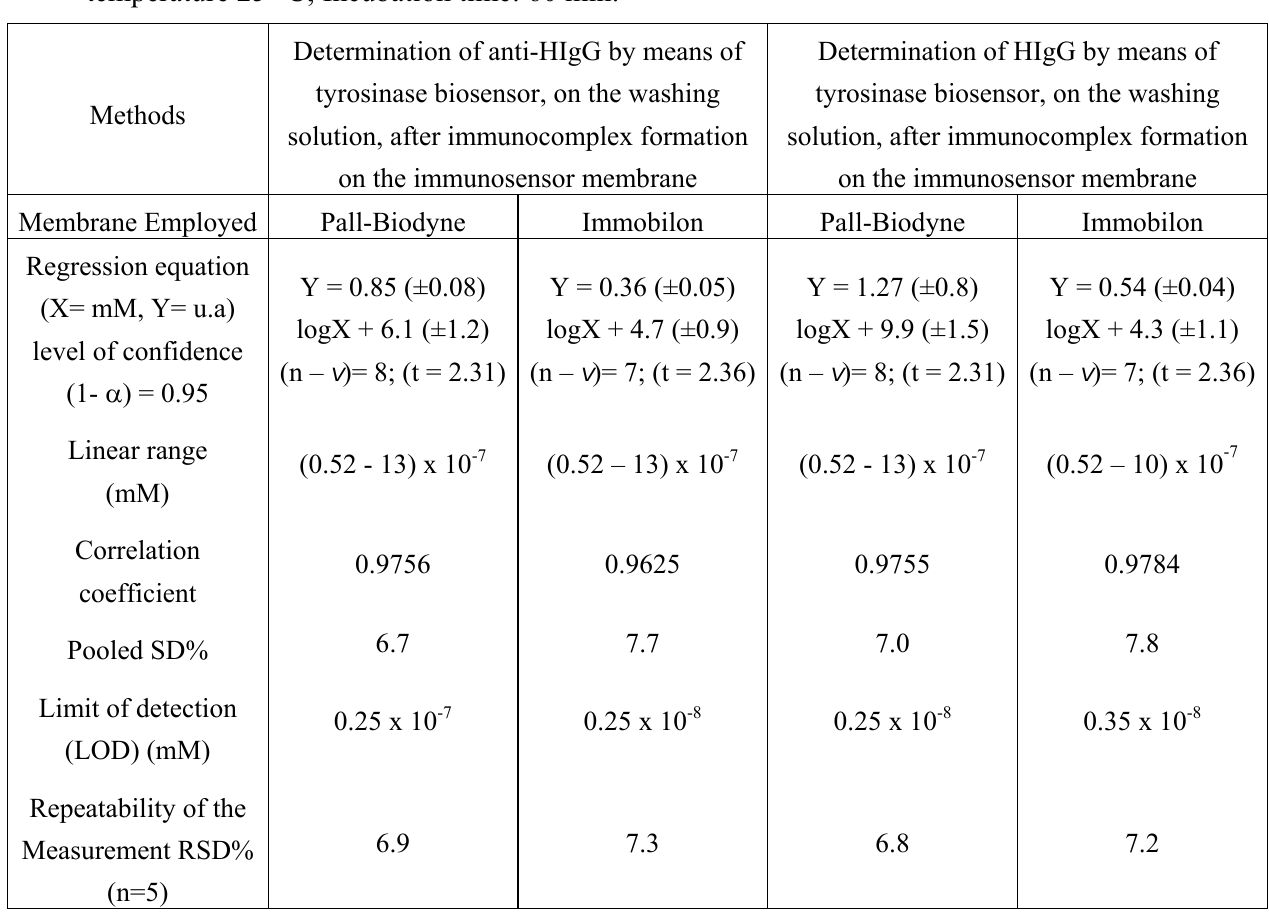
Table 3. Analytical characterization of biosensor method for anti-HIgG or HIgG determination, on the washing solution, using a simple tyrosinase biosensor for the measurement. Operating conditions: Buffer solution: Tris HCl 0.1 M, pH 8.0; Incubation temperature 25 °C; Incubation time: 60